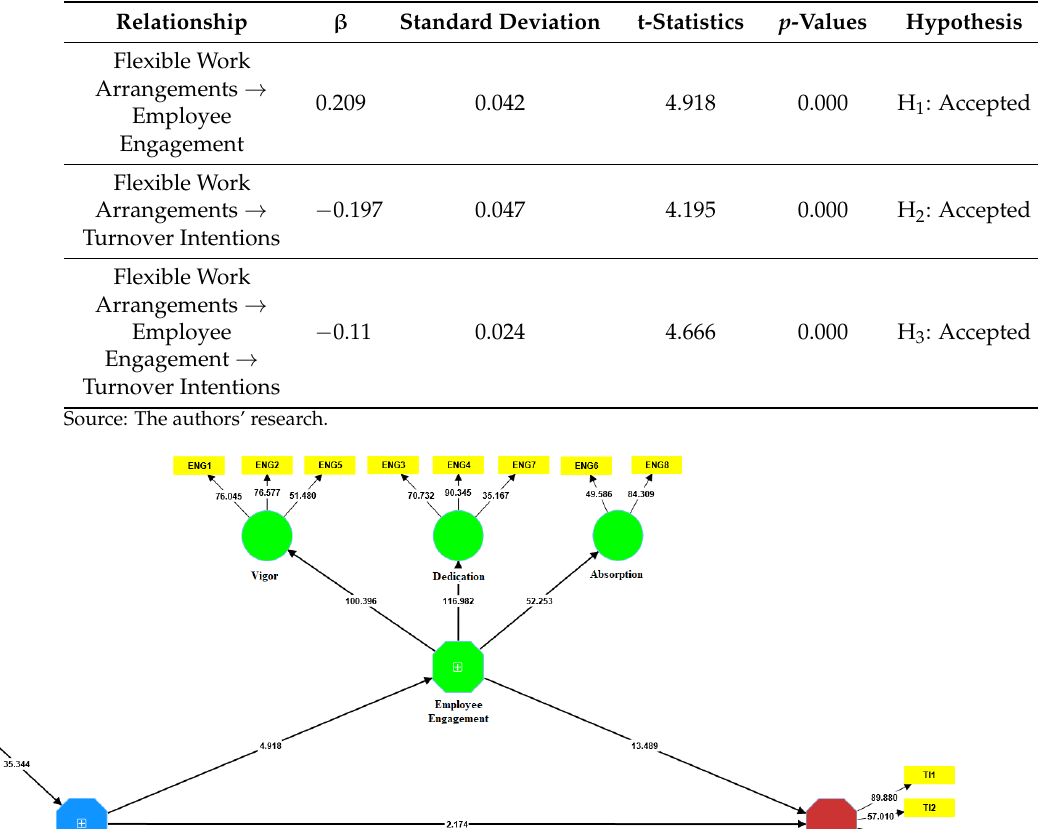
Table 12. Values of mean, standard deviation, t-statistics, and p -values of the structural model.